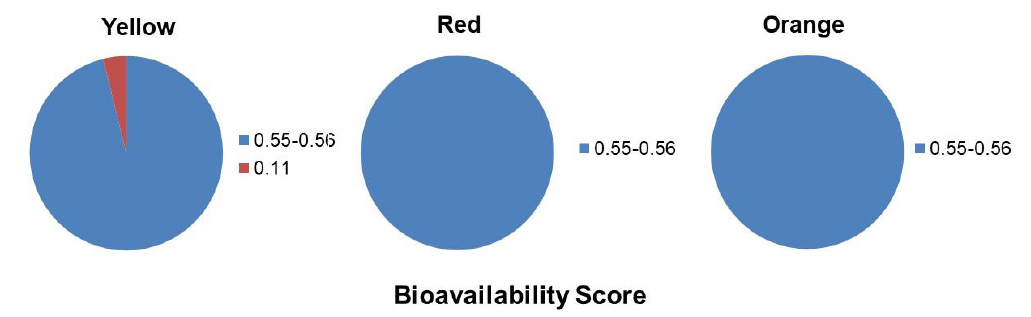
Figure 3. Distribution of drug-likeness (Lipinski range and Bioavailability scores) of the Monascus pigments.